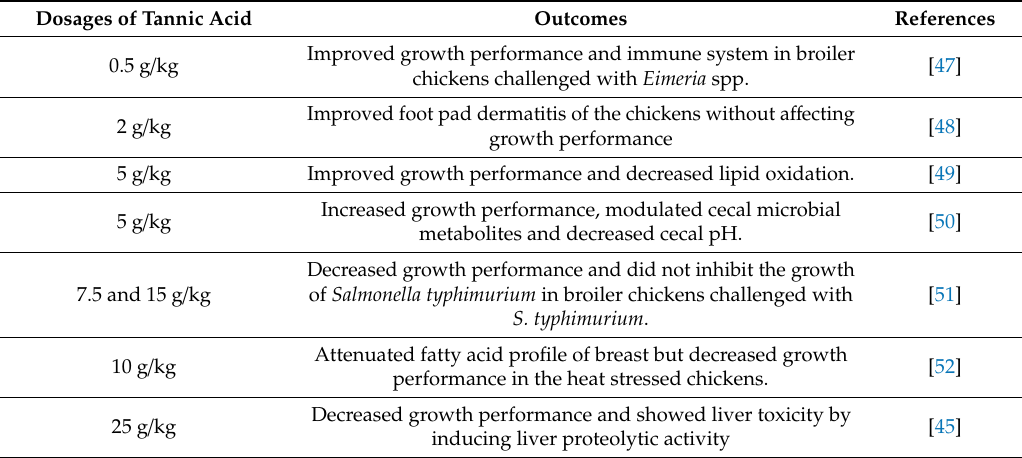
Table 1. E ff ects of di ff erent dosages of tannic acid on the broiler